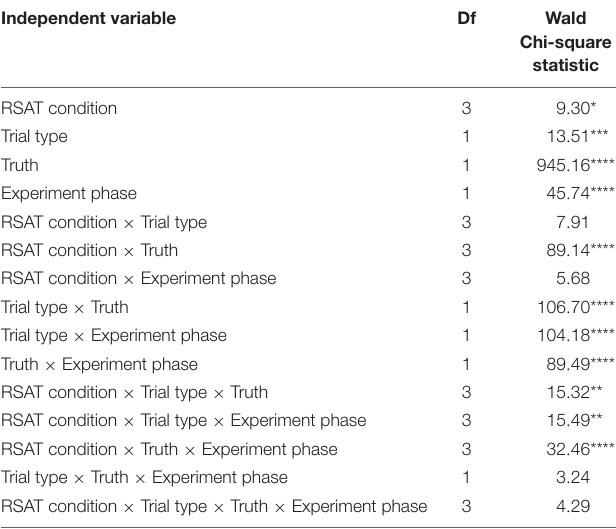
characteristics and task